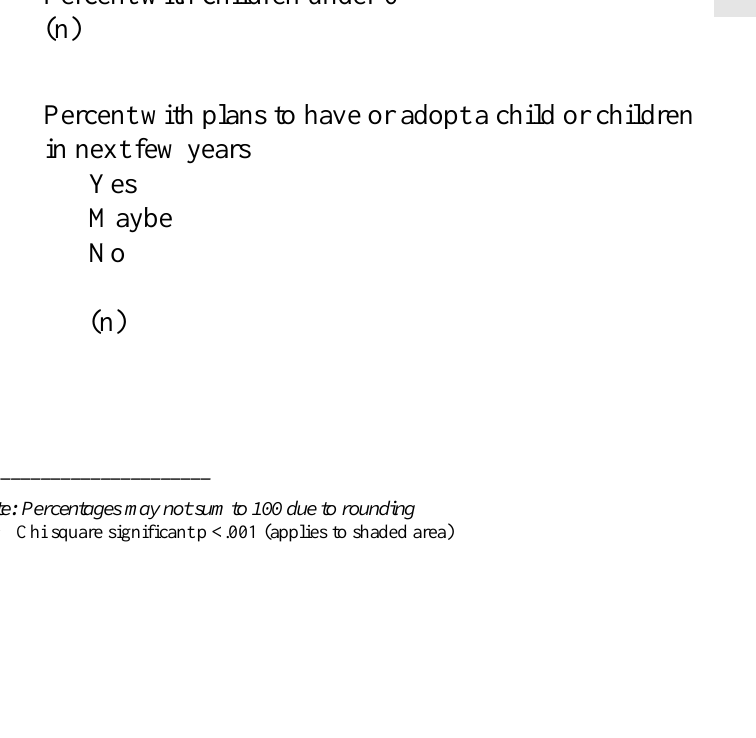
Table 20. Impact of Children on Careers (percent) Percent with children under